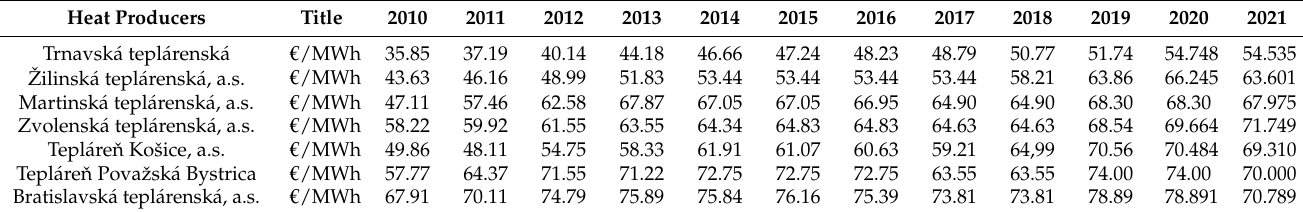
Figure 9. Natural gas prices for household consumers, first half 2021 [29]. Table 1. Development of heat prices in Slovakia [28].